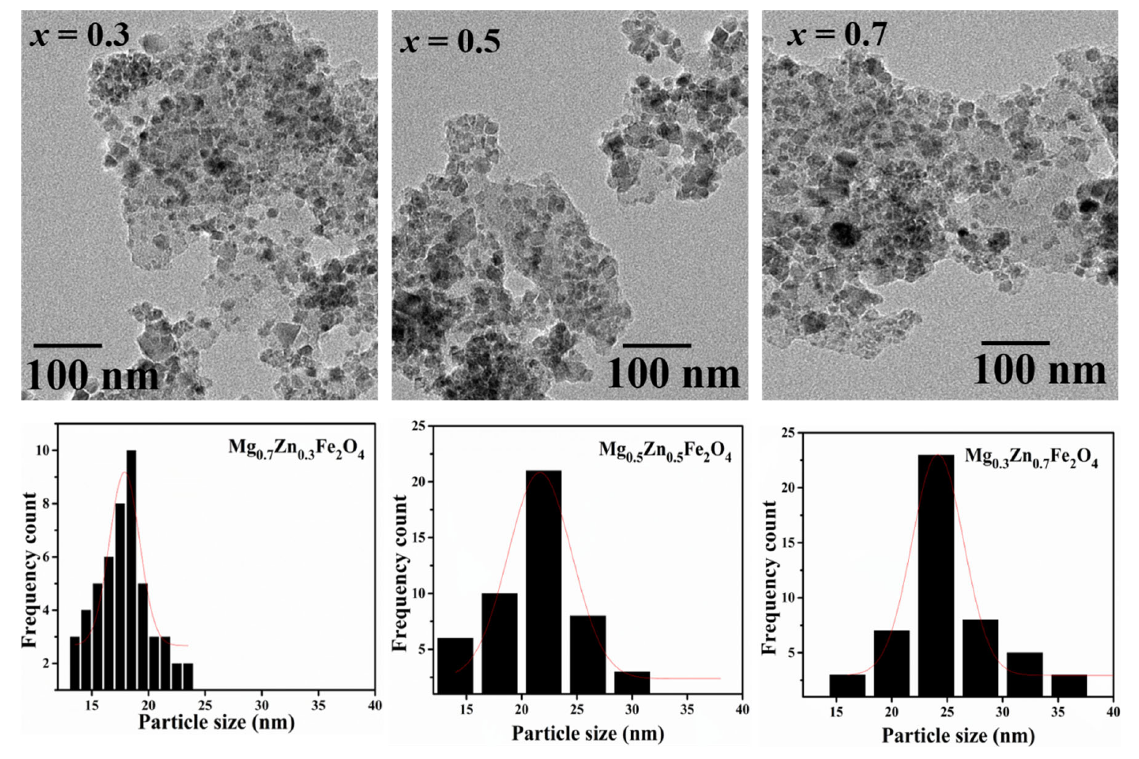
Fig. 4 TEM images and histograms of Mg 1– x Zn x Fe 2 O 4 NPs.